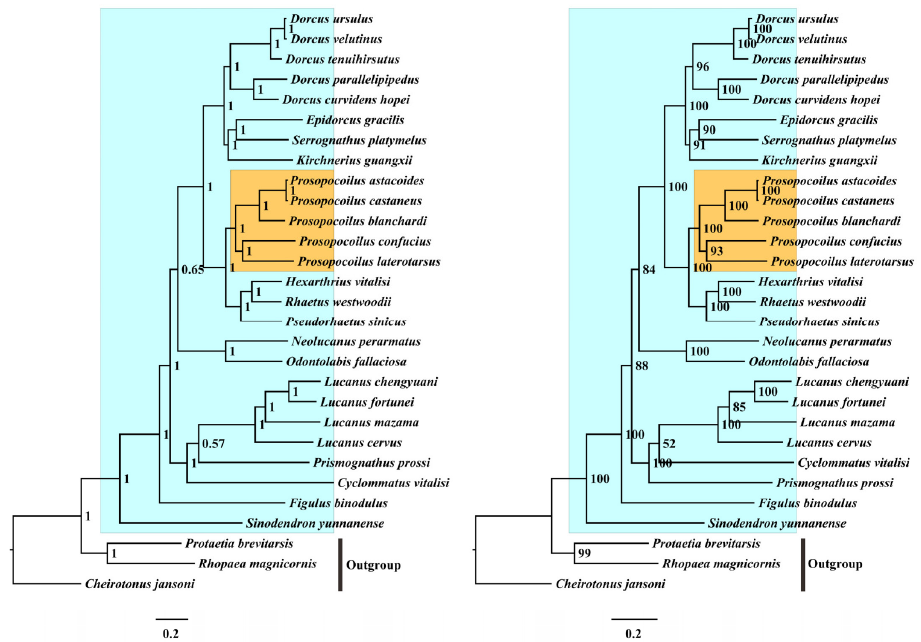
Figure 6. Phylogenomic relationships of Lucanidae inferred from mitogenomes. Three other scarab species ( Cheirotonus jansoni , Rhopaea magnicornis, and Protaetia brevitarsis ) were used as the outgroup. The phylogenetic topology was obtained based on the data set AA. Blue shading shows Lucanidae and yellow shading shows Prosopocoilus . The numbers at the nodes are BI posterior probabilities ( left ) and ML bootstrap values ( right ).